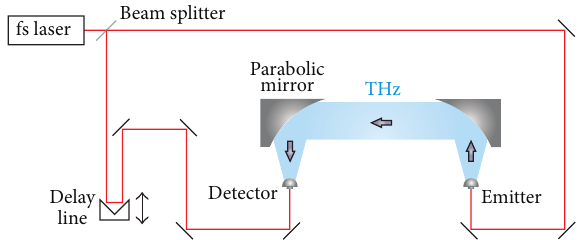
Figure 1: Operation principle of photoconductive antennas. The laser beam is focused on the dipole gap, the dipole gap, generating electron-hole pairs, and the transient current conditioned by the applied voltage 𝑈 𝑏 emits an electromagnetic pulse of subpicosecond duration—the THz pulse—into the free space. The emitted wave- lengths are much longer compared to the size of their source, the dipole; hence, they diffract strongly in the form of a wide cone filling out almost the whole solid angle behind the antenna (dark grey area marked THz).